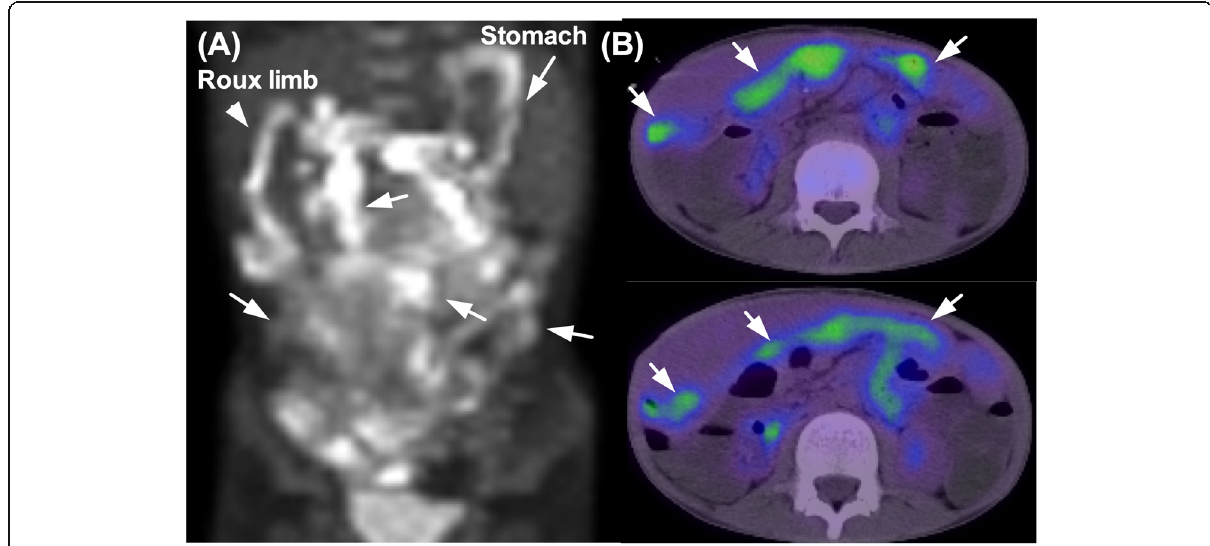
Fig. 2 PET-CT: PET-CT revealed a wide range of the small intestine increased FDG activity. a The image of the whole abdomen in FDG activity. a , b The arrowhead indicates the jejunum of the Roux limb. The arrows indicate the stomach and small intestine with increased FDG activity